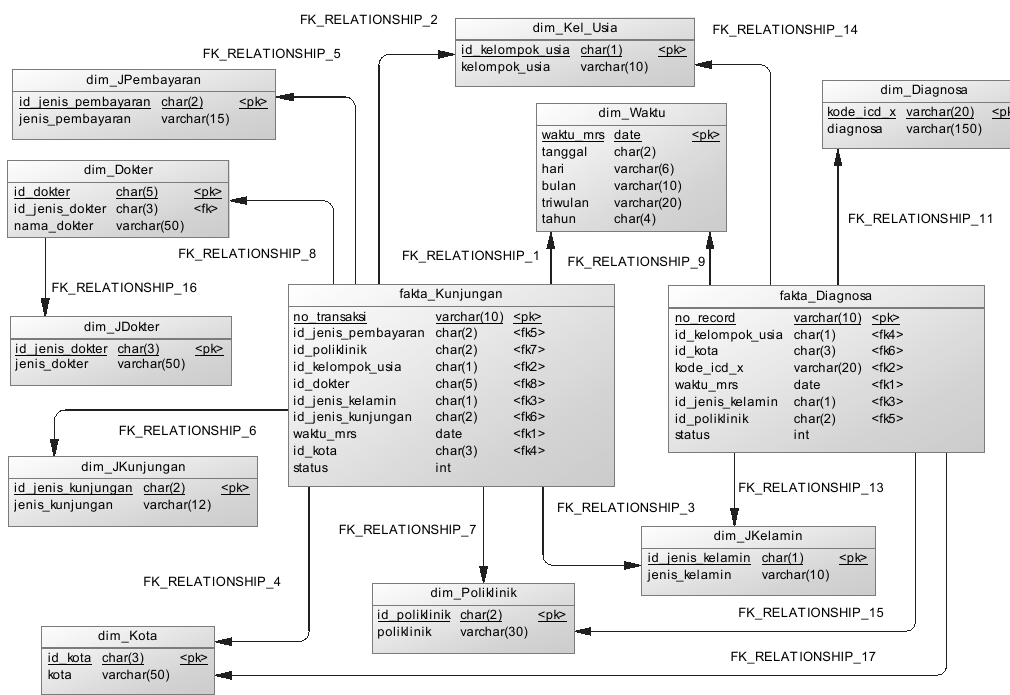
Gambar 1. Physical Data Model